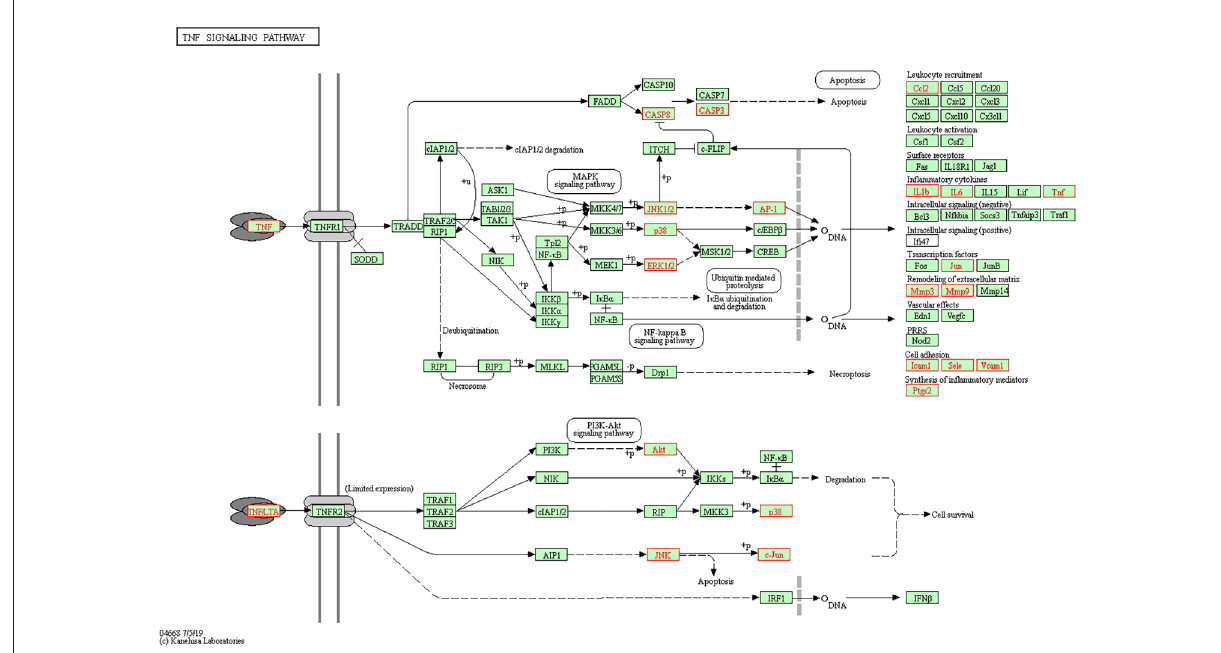
FIGURE8 TNF signaling pathway. The red targets are the hub genes which involved in the therapeutic effect of Epimedium on